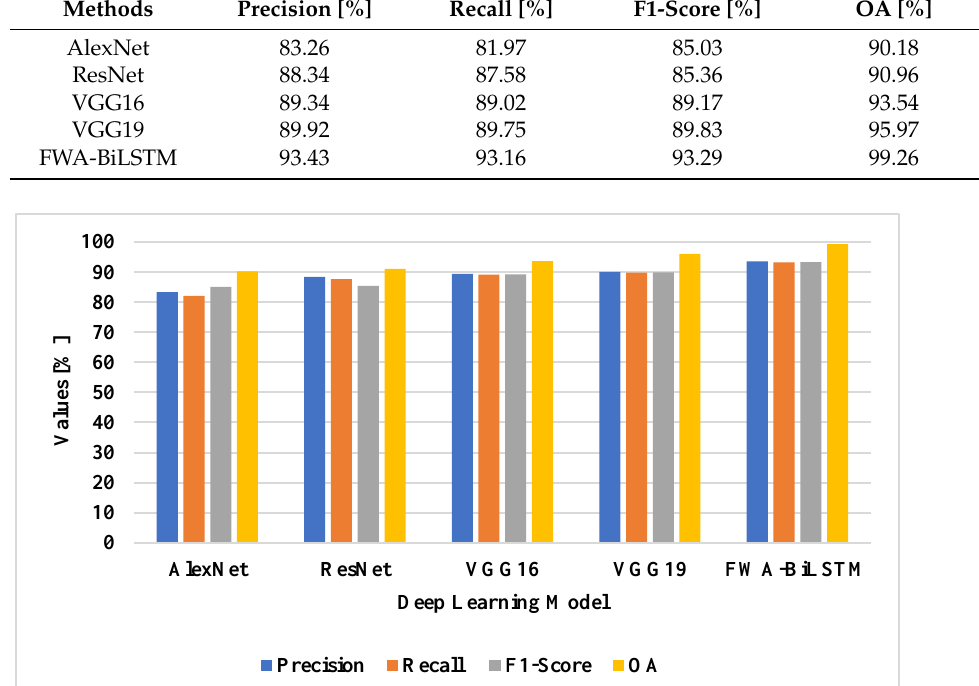
Figure 7. Classifier with attention layer on LEVIR-CD dataset.